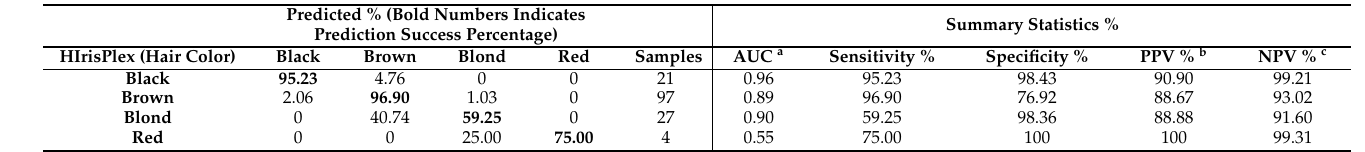
Table 2. The classification for each different hair color category and summary statistics (AUC, sensitivity, specificity, PPV, and NPV) using HIrisPlex for the Turkish population. Predicted % (Bold Numbers Indicates Prediction Success Percentage) Summary Statistics